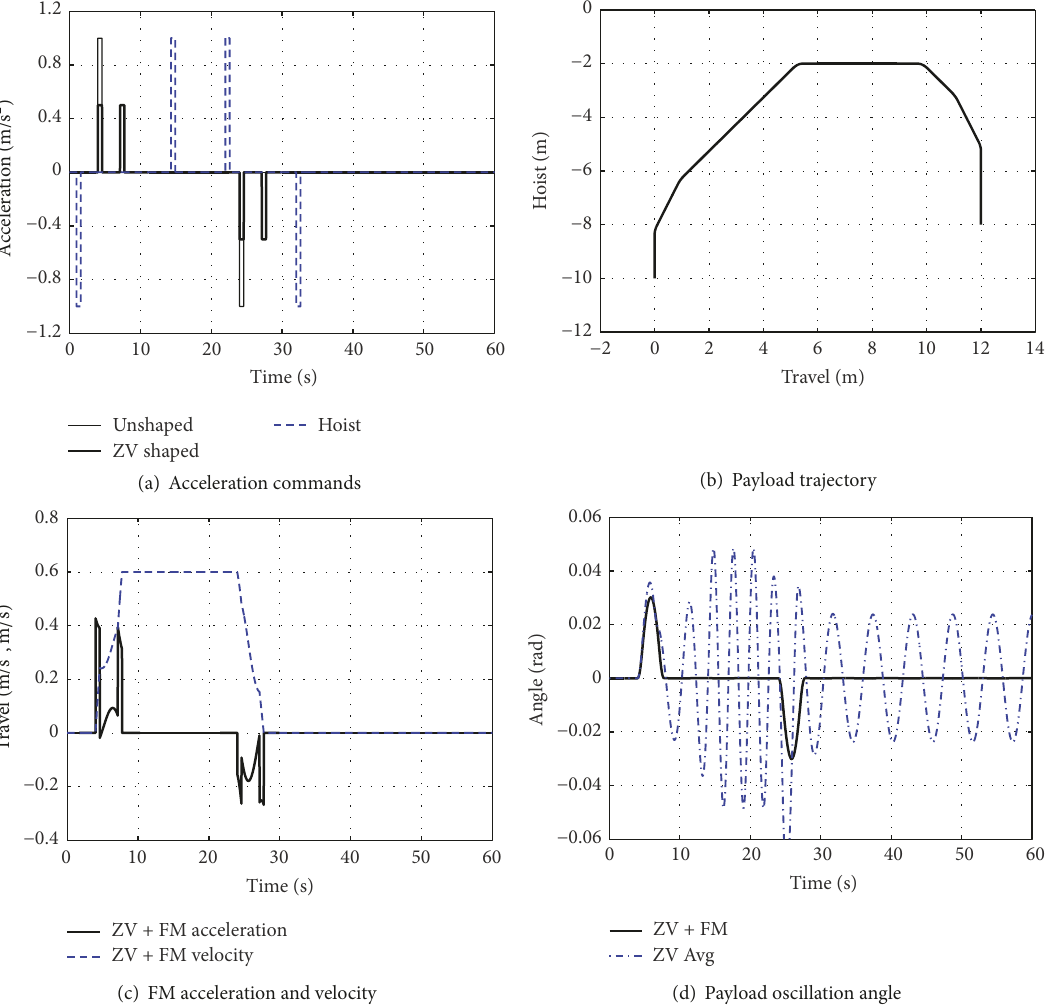
Figure 5: Simultaneous travel and hoisting maneuver using FM shaped command with primary ZV input shaper.